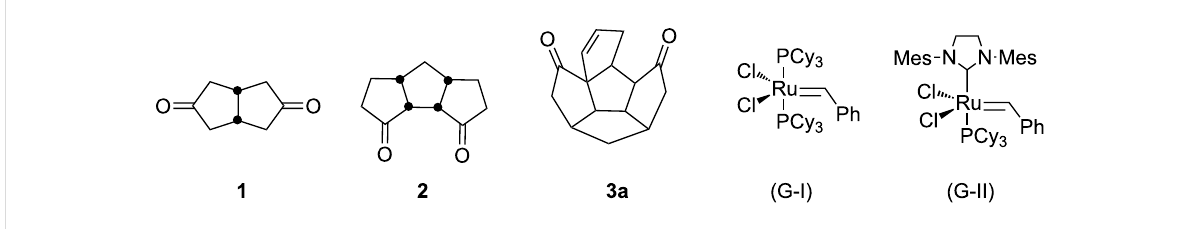
Figure 2: Quinane building blocks ( 1 – 3 ) and metathetic catalyst used in our strategy.